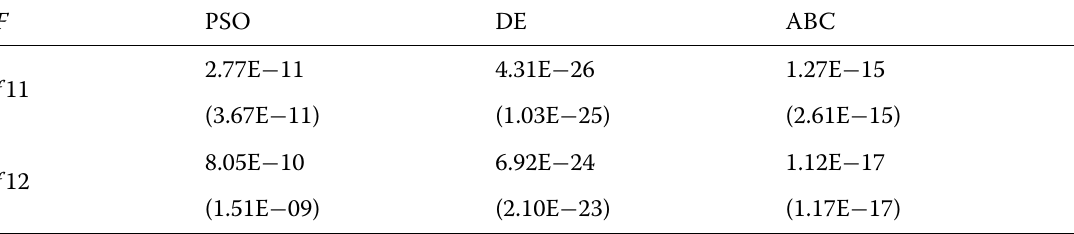
Table 9 Comparison results (1), D = 2 F